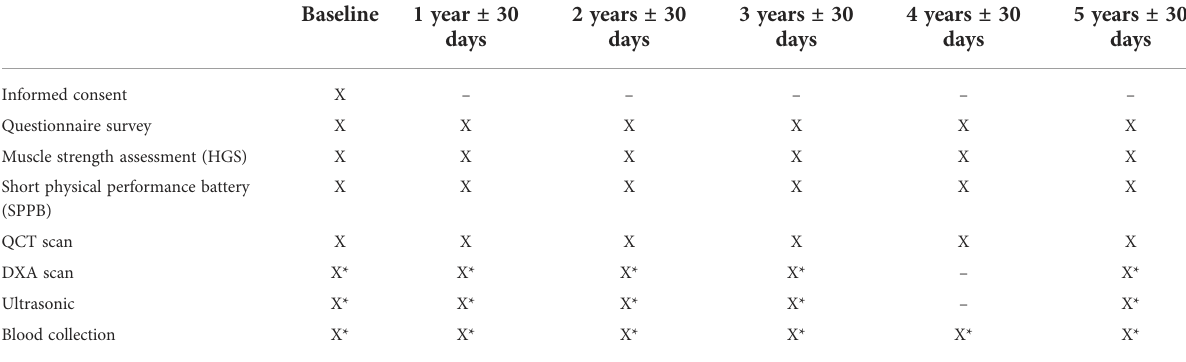
TABLE 1 Items and procedures of the study at baseline and each follow-up.